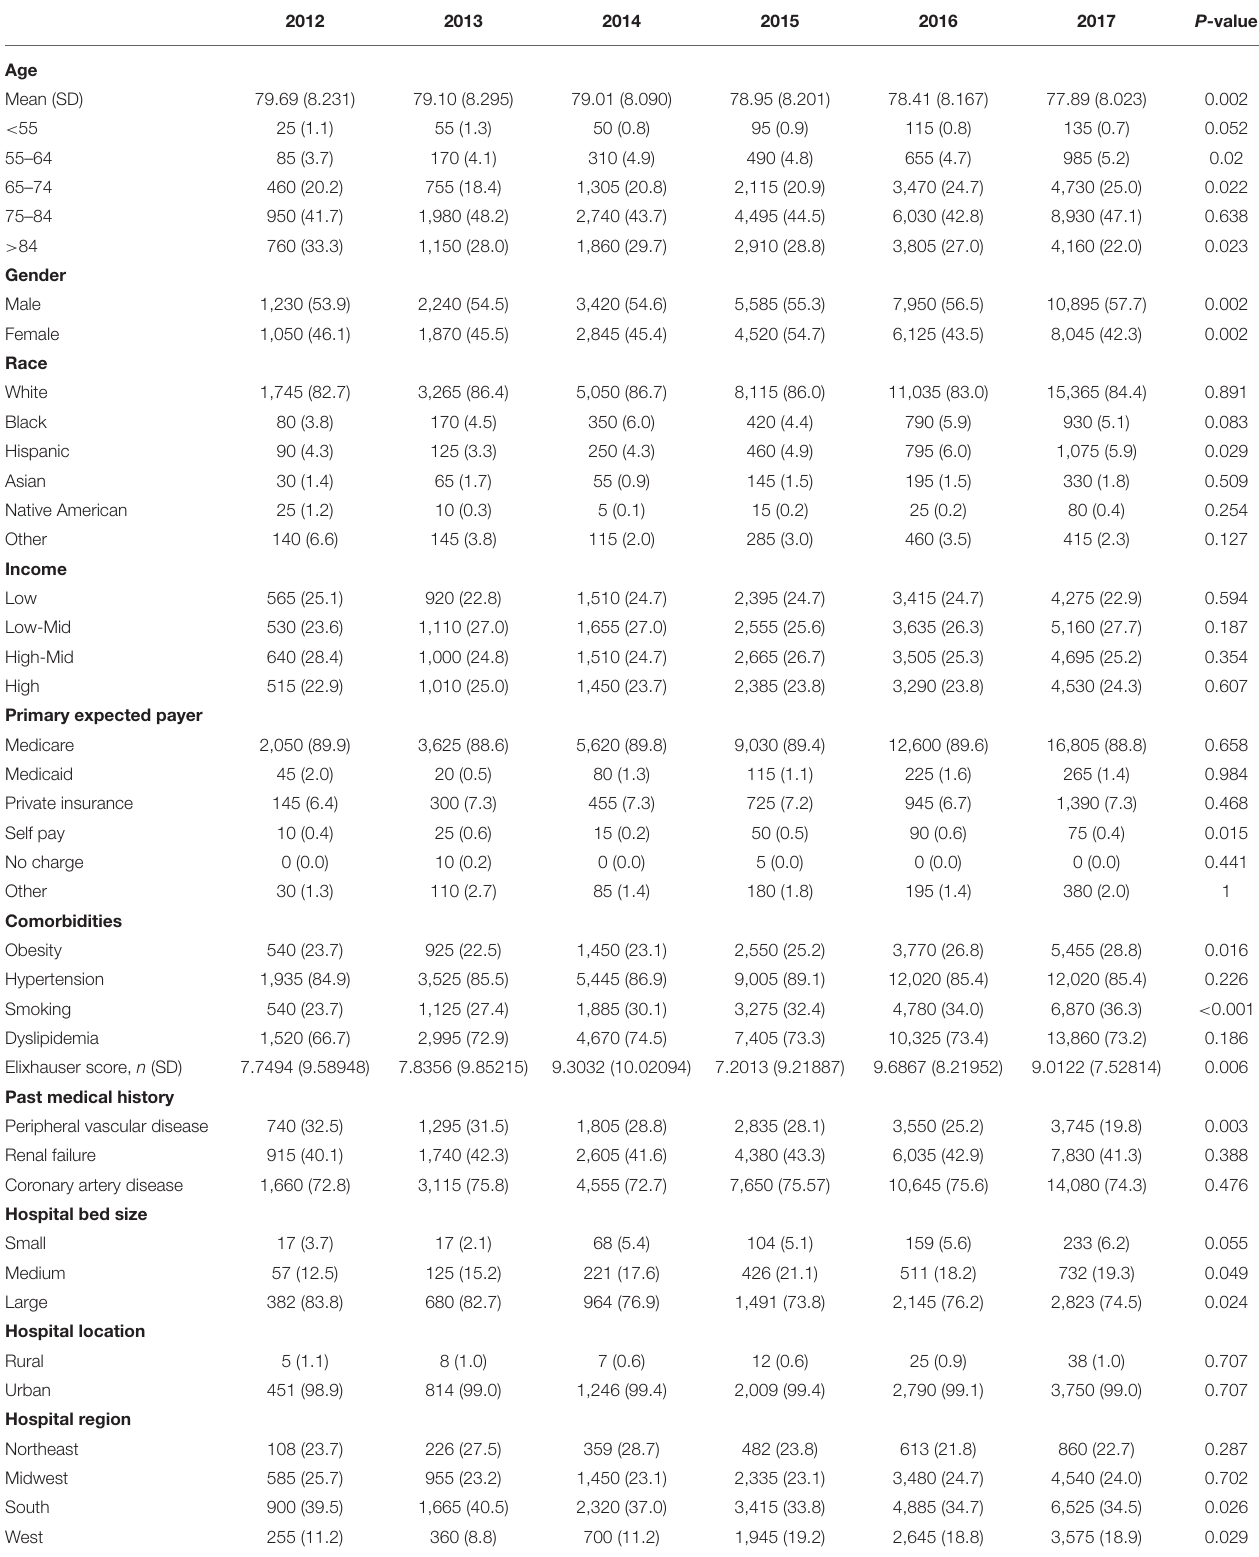
TABLE 1 | Baseline characteristic of patients with diabetes undergoing